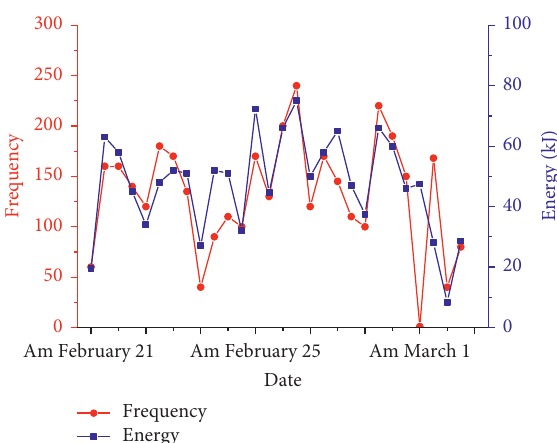
Figure 12: Geoacoustic monitoring results during